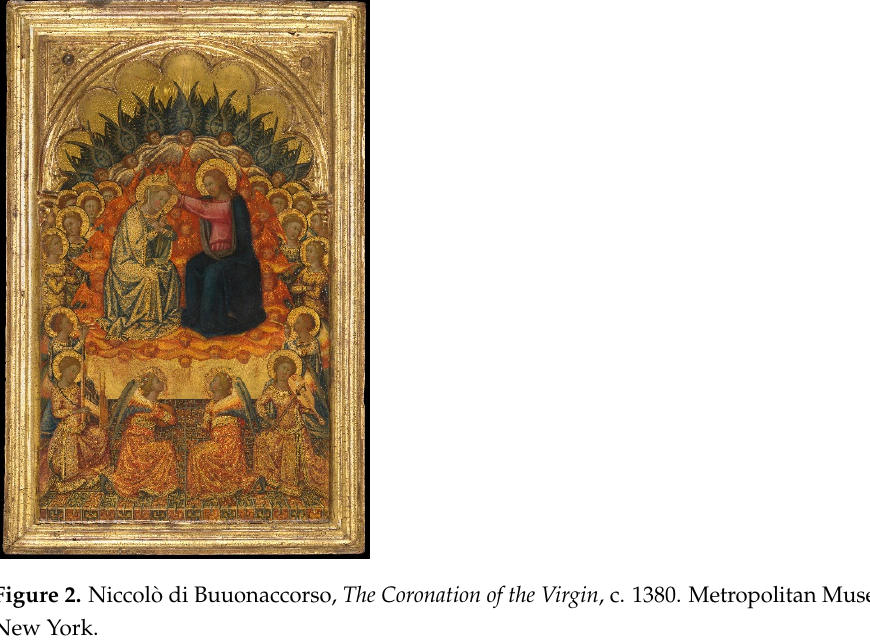
Figure 2. Niccolò di Buuonaccorso, The Coronation of the Virgin , c. 1380. Metropolitan Museum of New Art, New York.